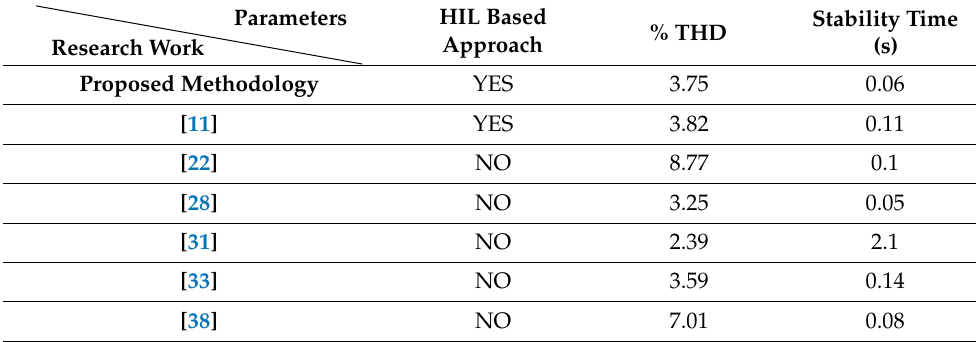
Table 5. Comparison of Proposed Methodology with Existing